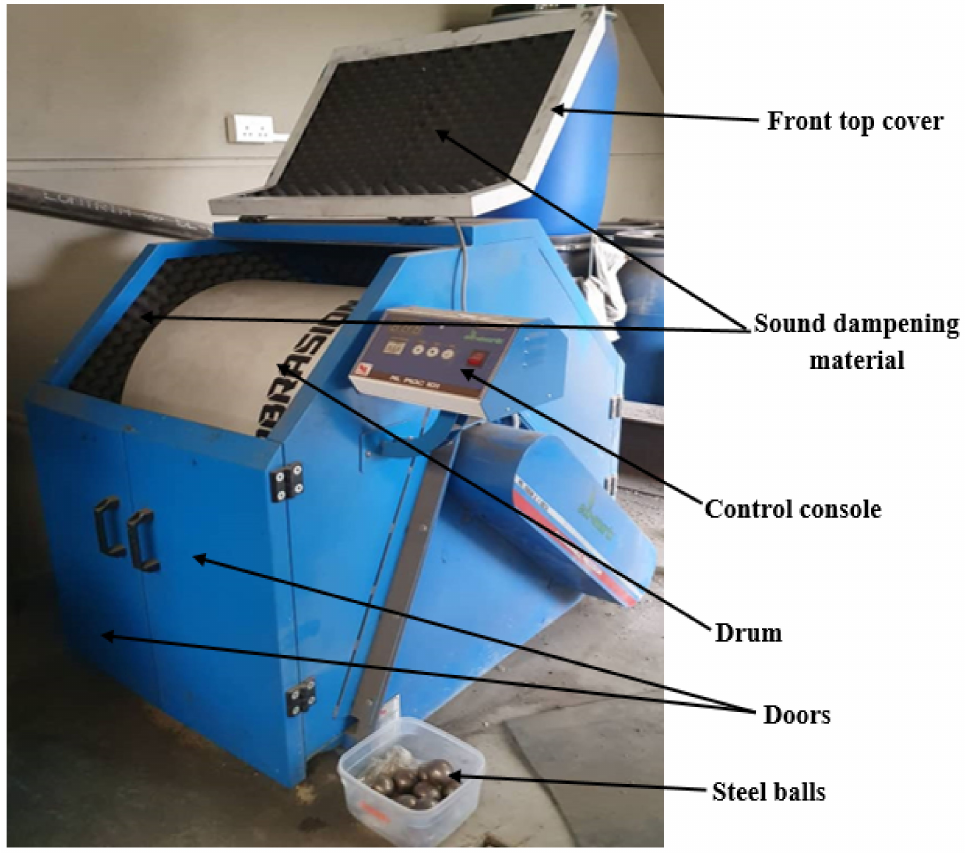
Figure 1. Eco-smartz Los Angeles Abrasion